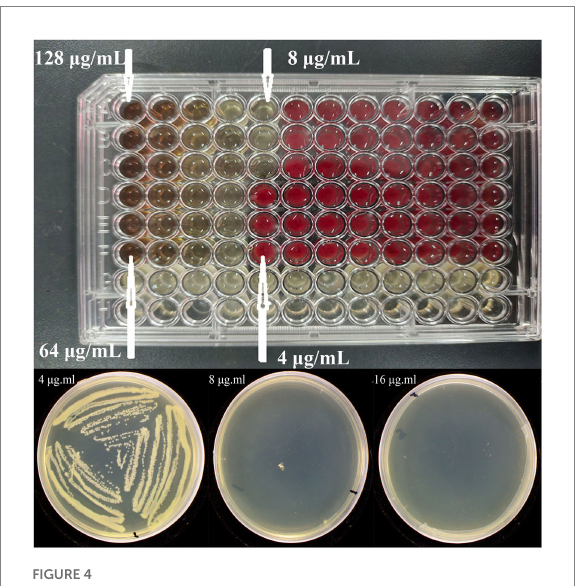
FIGURE 4 The MIC and MBC results of Mf-AgNP against P. carotovorum . The top and bottom images are the MIC and MBC results,